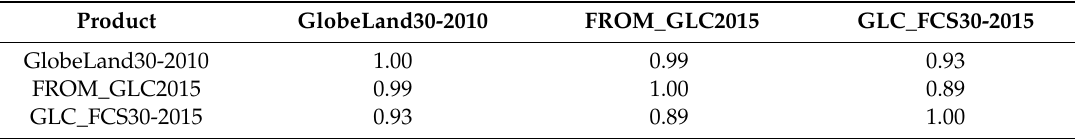
Figure 5. Area comparisons of di ff erent products. Table 5. Area correlation coe ffi cients between di ff erent